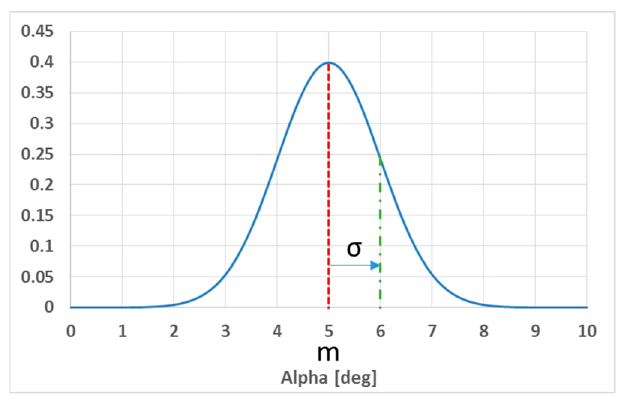
Figure 24. Normal pdf input of flow angle. Table 3. Main statistical moments for the output probability density